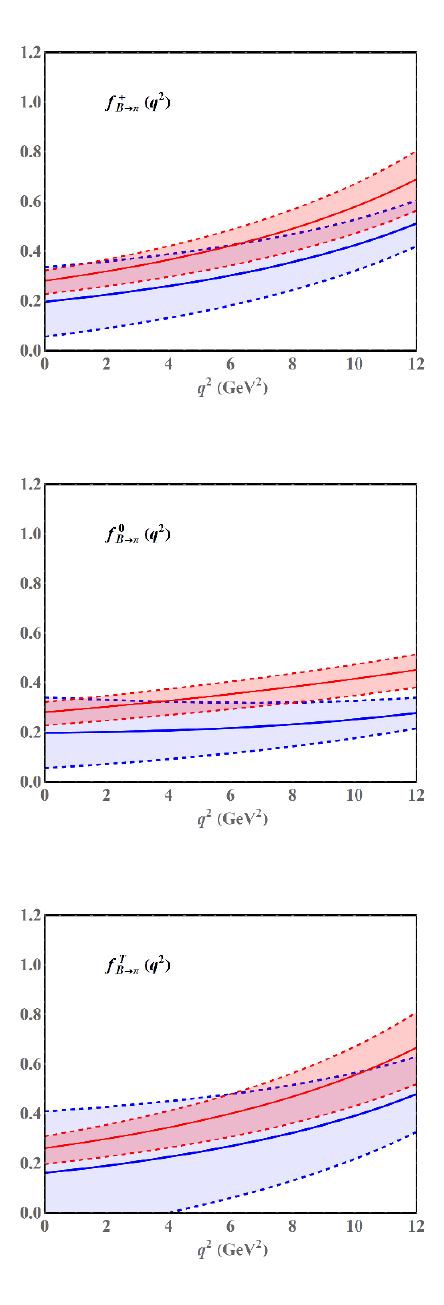
Figure 7 . The momentum-transfer dependence of B ! (cid:25); K form factors predicted from the B - meson LCSR are displayed with the pink bands. For a comparison, we also present the Lattice QCD calculations from Fermilab/MILC Collaborations [1{3] with an extrapolation to small q 2 in terms of the z -series expansion (5.15) as indicated by the blue bands.